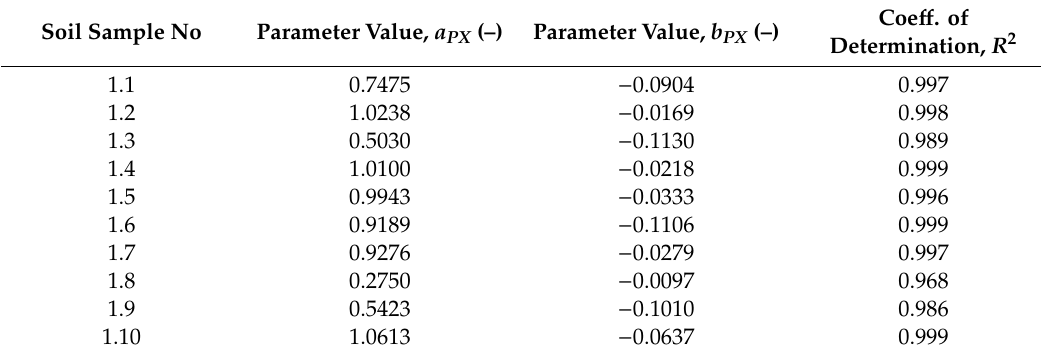
Table A1. The cyclic triaxial test loading